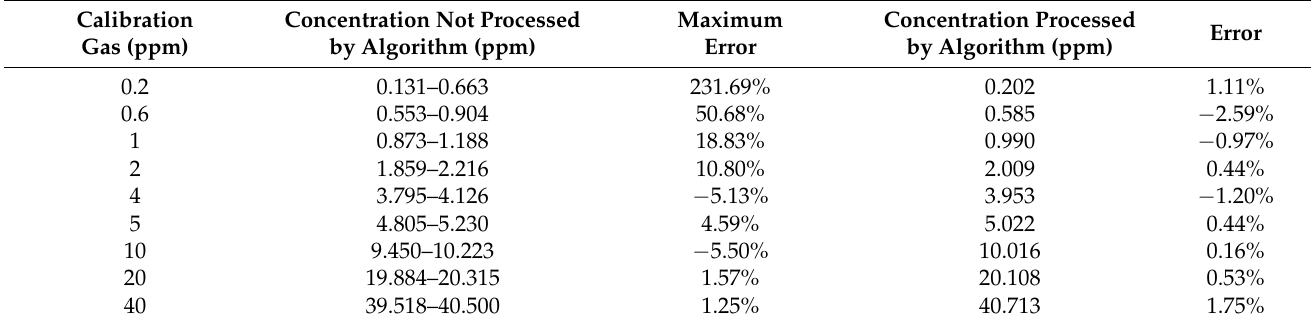
Table 2. The concentration of original spectra with two processing methods.